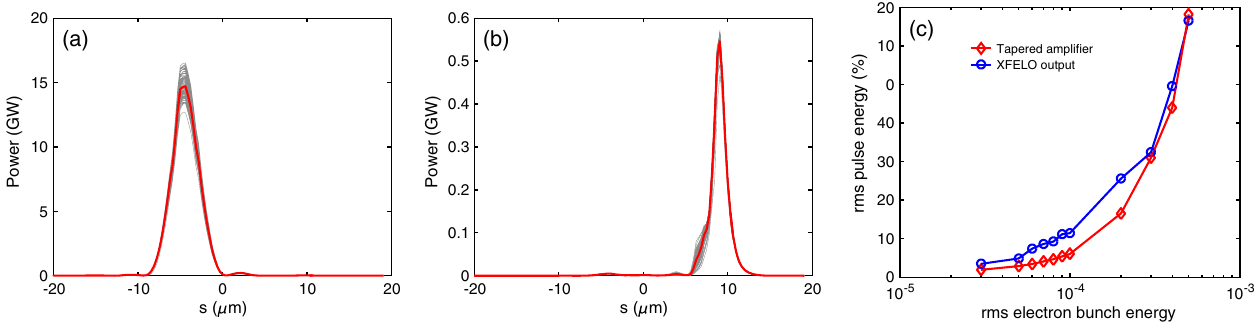
FIG. 8. The output radiation of (a) XFELO and (b) tapered FEL amplifier. The gray lines refer to 100 runs with 10 − 4 rms beam energy jitter, and red line is the average value. Subfigure (c) shows the rms of output energy with different rms beam energy